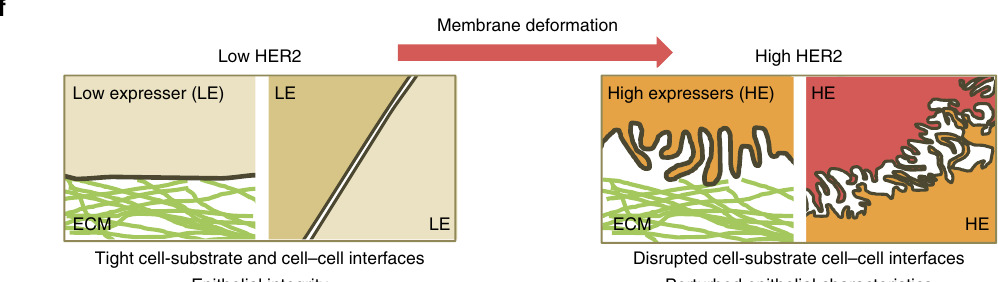
Figure 5 | The membrane deformation disrupts cell interfaces. ( a ) Processed images of raw IF data (similar images are shown in Supplementary Fig. 7a,b) acquired from TIRFM imaging of HER2 (red, a H2Fab:QD), integrin beta 1 (ITGB1; blue, a CD29:alexa568) and paxillin (green, a paxillin:Alexa488) in MCF-7-HER2 cells showing the relative locations of these proteins. Less overlap between HER2 and ITGB1 is observed than between ITGB1 and paxillin. Scale bars, 5 m m. ( b ) IF images of paxillin distributions in basal cell membranes of various MCF-7 transfectants. The Paxillin distributions in all high HER2 expressers (3 þ ; wtHER2 and the two signalling-incompetent HER2 mutants) are irregular compared to the more uniform distribution in the low HER2 expresser MCF-7-vctrl. Scale bars, 20 m m. ( c ) Average cell-surface coverage (mean ± s.e.m.) of paxillin clusters (normalized (Nor.). Paxillin coverage) was calculated from the ratio of the area covered with paxillin (FLS greater than B 13% of the maximum intensity) to the total cell-surface area. *** P value o 10 (cid:3) 6 by two-sided, unpaired Welch’s t -test. ( d ) Confocal IF images of E-cadherin (green, a E-cadherin:alexa488) in various MCF-7 transfectants. Scale bars, 30 m m. ( e ) Confocal IF images of HER2 (red, a H2Fab:QD) and E-cadherin in MCF-7-wtHER2 (left panels) and MCF-7- D icdHER2 (right panels) co-cultured with MCF-7-vctrl to contrast the delocalized patterns of E-cadherin in high HER2 expressers (red arrows) with the localized E-cadherin distributions in low expressers (green arrows). Scale bars, 20 m m. ( f ) A cartoon illustrating how the HER2-induced membrane deformation perturbs cell–substrate and cell–cell interfaces, and thus disrupts epithelial integrity. Shades of beige and red represent different